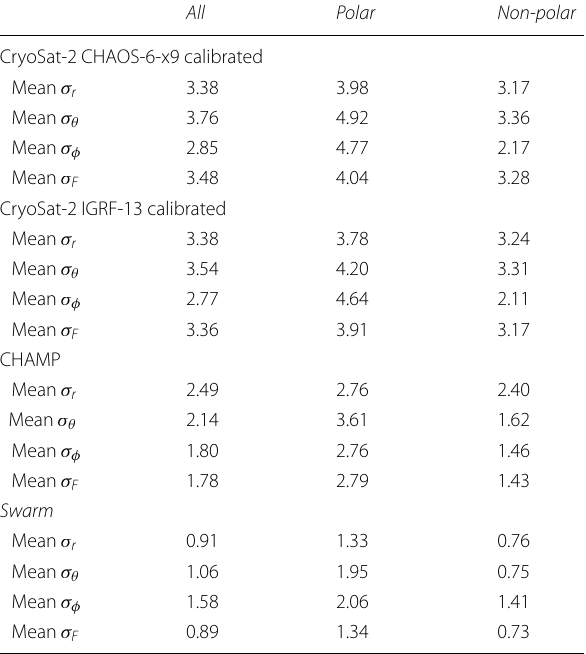
Table 3 Mean of the rms differences (in nT/year) between GVO SV series and GCV cubic spline fits. Results are shown for both the CHAOS-6-x9 and IGRF-13 calibrated CryoSat-2 datasets, and for GVO SV series derived using Swarm and CHAMP data All